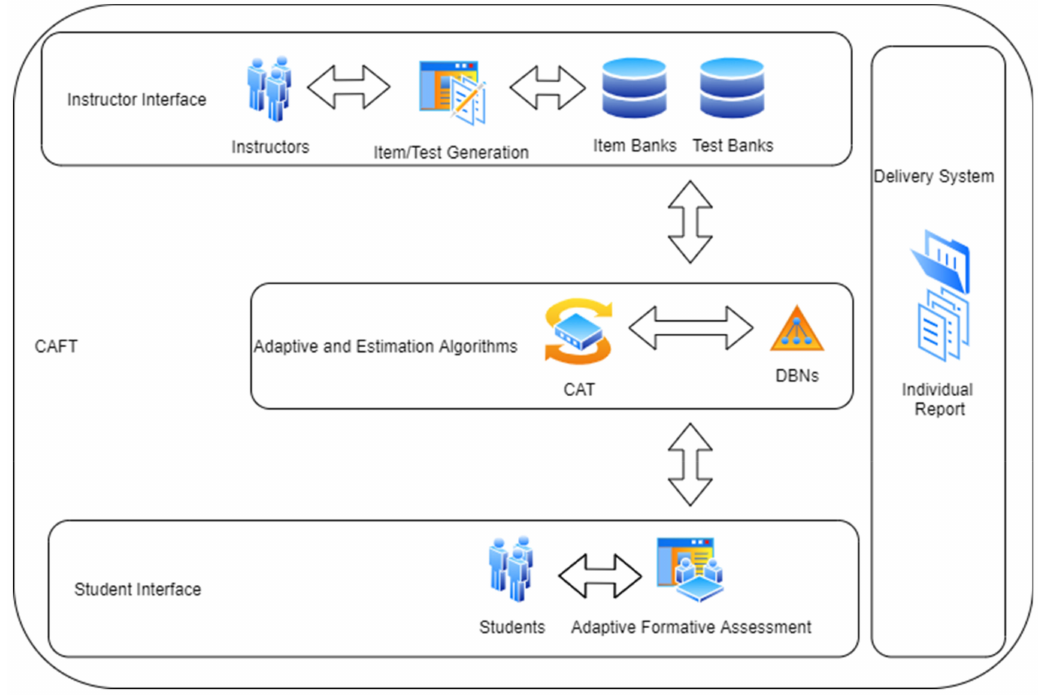
Figure 2. A system of computerized formative adaptive testing (CAFT)